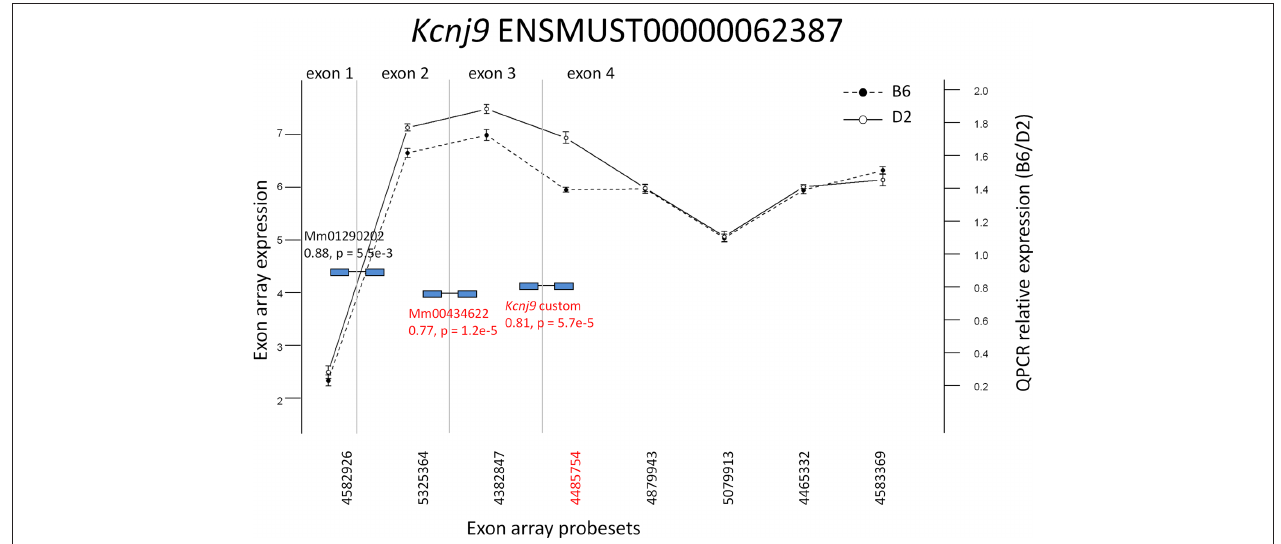
FiguRe 6 | exon array expression at probeset-level and confirmation by qPCR. Exon array probesets indicated in red are the largest exon delta for a transcript detected as significant by the algorithm for ( q < 0.05) strain by probeset interaction in whole brain. TaqMan (Applied Biosystems, Foster City, CA, USA) qPCR probes spanning exons are indicated in blue. Those with p < 0.005 are indicated in red as differentially expressed. The vertical lines indicate exon boundaries and are not drawn to scale.